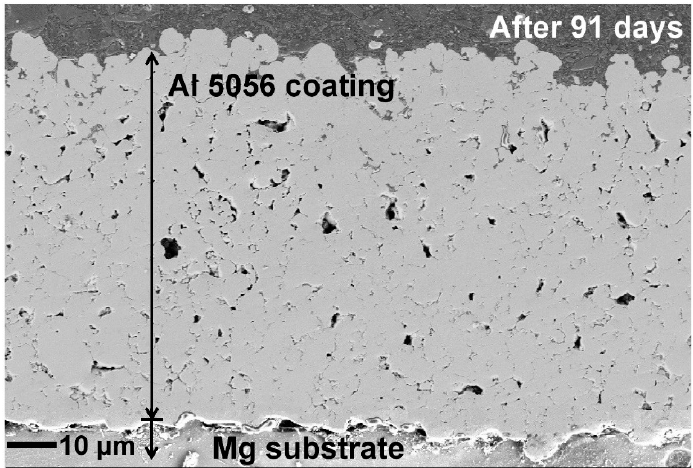
Figure 10. Cross-sectional SEM micrographs of the cold-sprayed Al 5056 coating on the magnesium substrate after immersion in 0.1 M Na 2 SO 4 solution for 91 days.